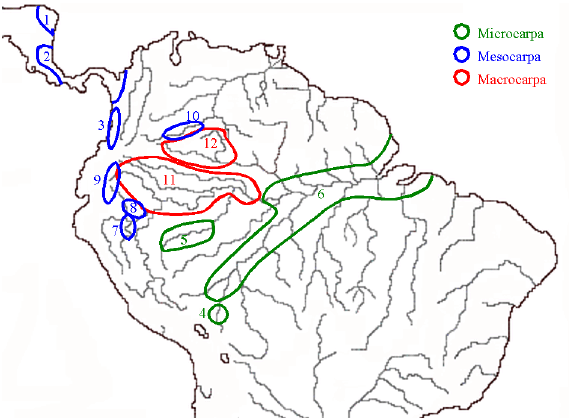
Figure 2. Geographical distribution of landraces of Bactris gasipaes var. gasipaes : 1. Rama, 2. Utilis (including Guatuso and Tuira), 3. Cauca, 4. Tembé, 5. Juruá, 6. Pará,